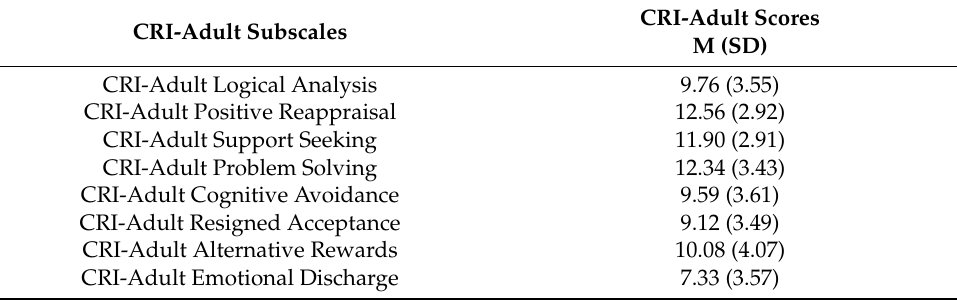
Table A1. CRI-Adult scores obtained by patients with MS.